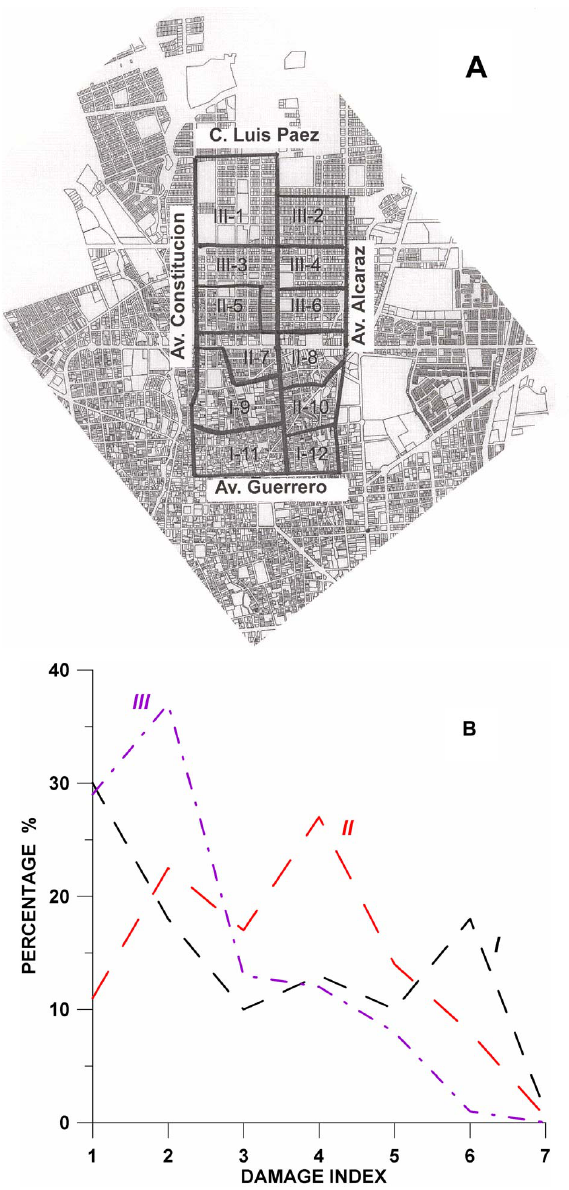
Fig. 3. Three zones (a) of the characteristic Colima infrastructure (I, II, III) where the macroseismic study after the 2003 earthquake (Zobin et al., 2006) was carried out and the distribution of the 2003 earthquake damage to 3332buildings situated within these three zones (b) . Indexes I, II, and III at the curves in (b) correspond to the damage distribution for three zones.